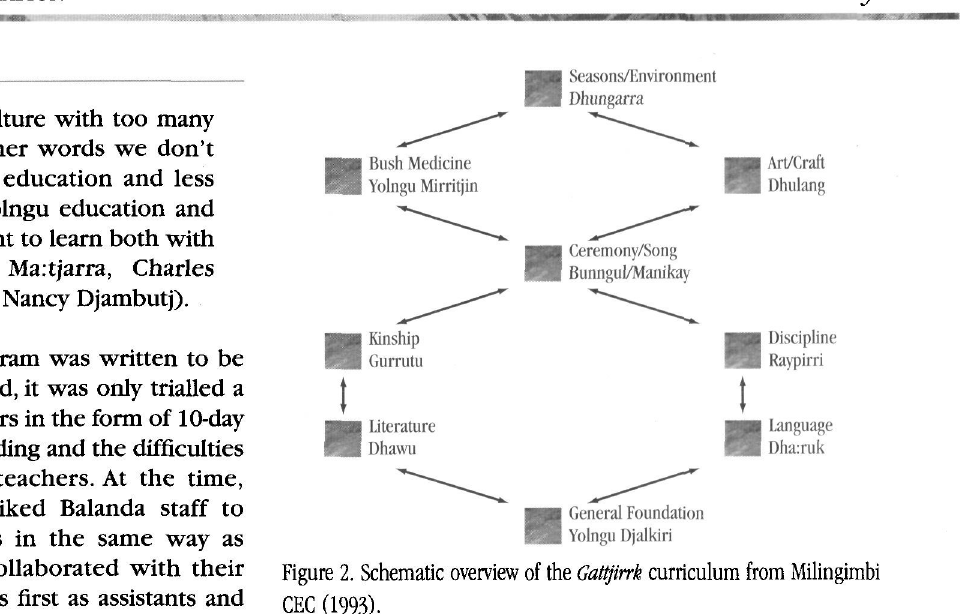
Figure 2. Schematic overview of the Gattjirrk curriculum from Milingimbi CEC